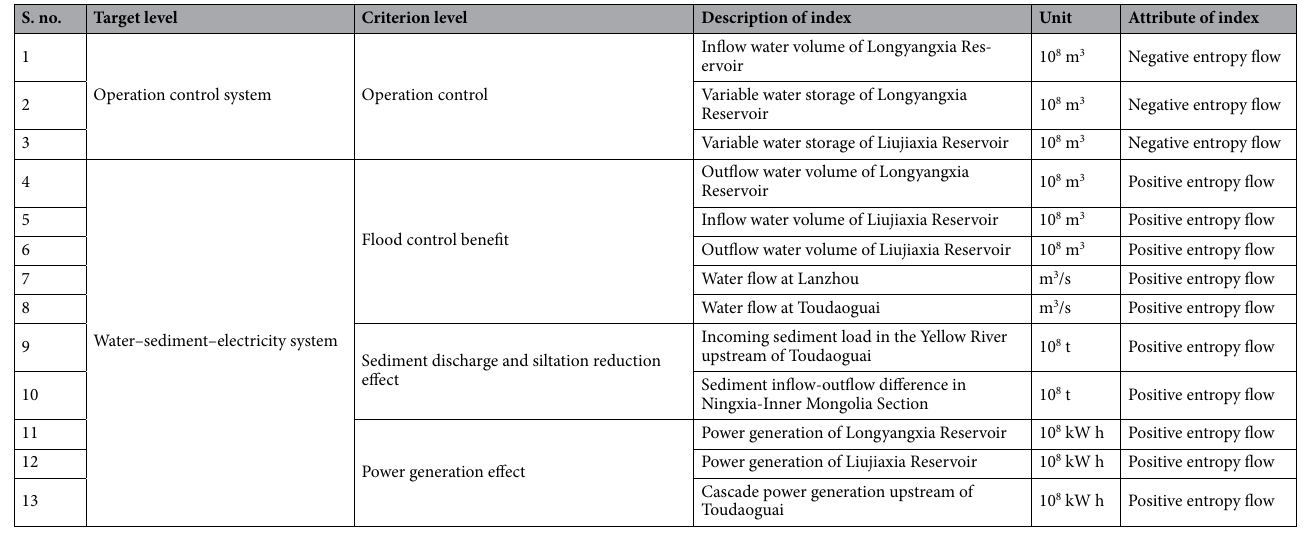
Table 1. Construction of evaluation index system.